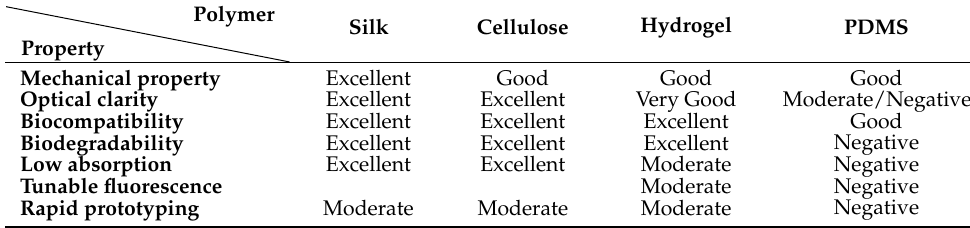
Table 1. Comparison between the proposed biopolymers with respect to PDMS.